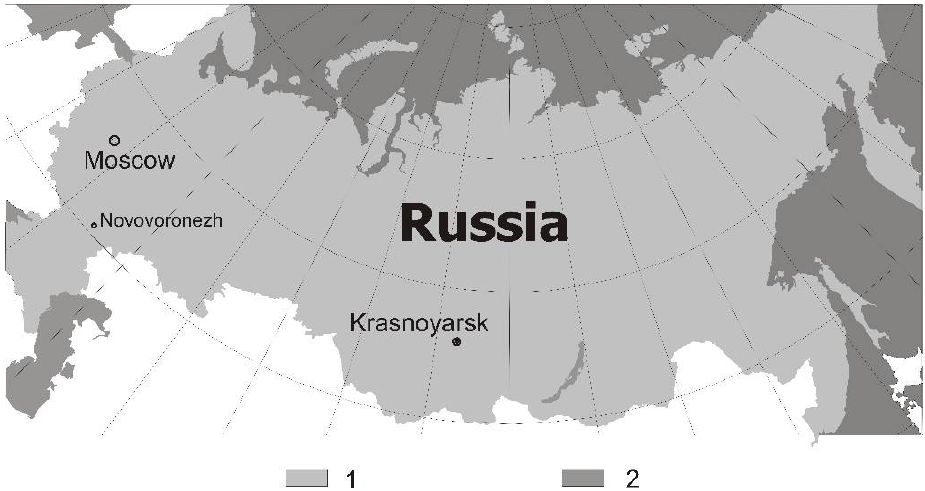
Figure 1. Location of Novovoronezh and Krasnoyarsk. (1) Territory of Russian Federation; (2) seas and lakes.